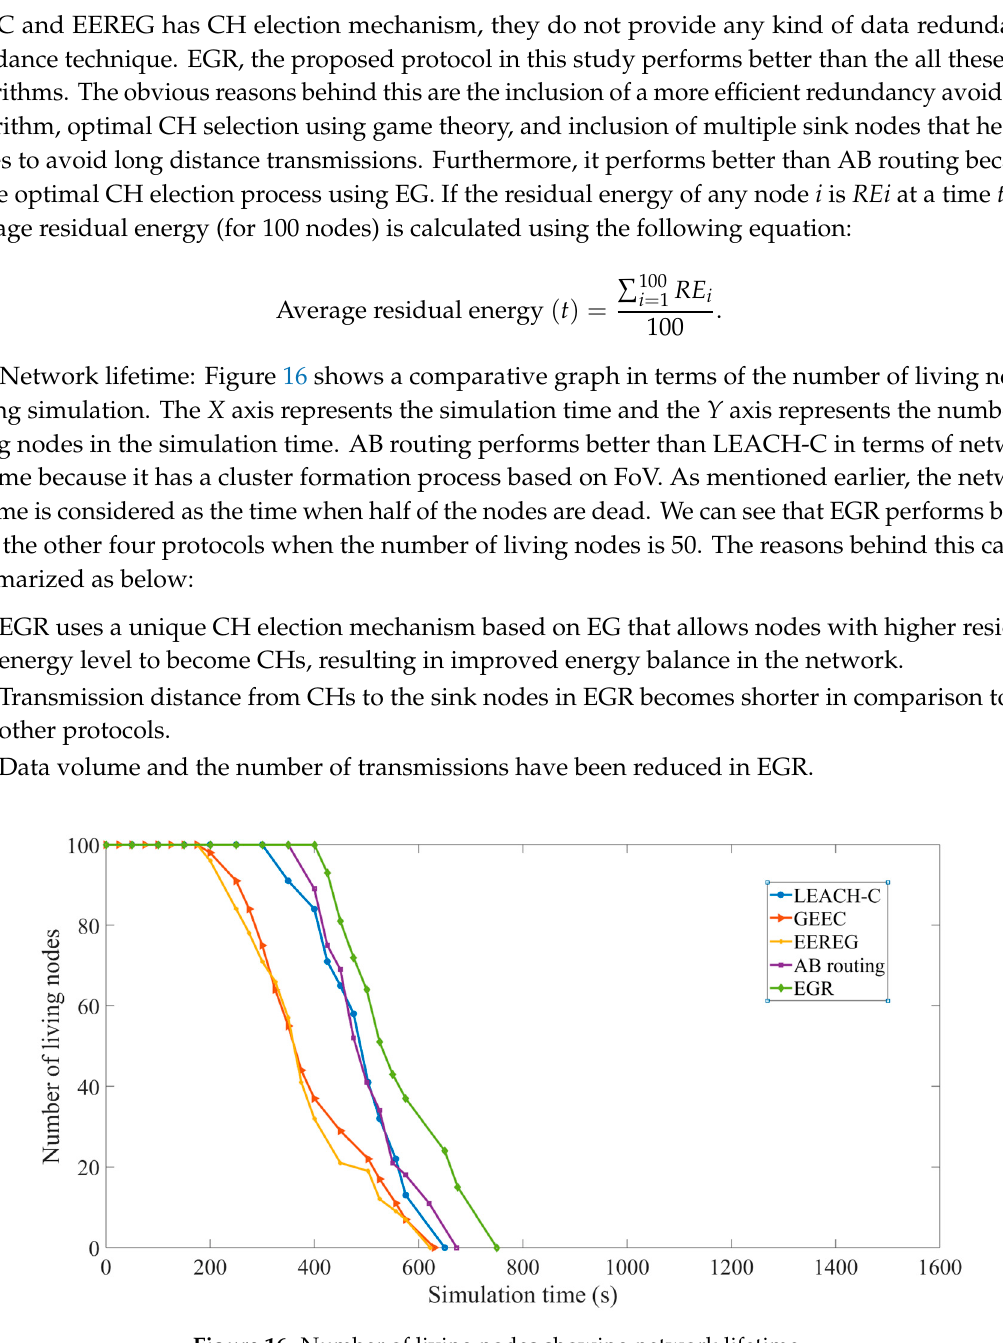
Figure 16. Number of living nodes showing network lifetime.